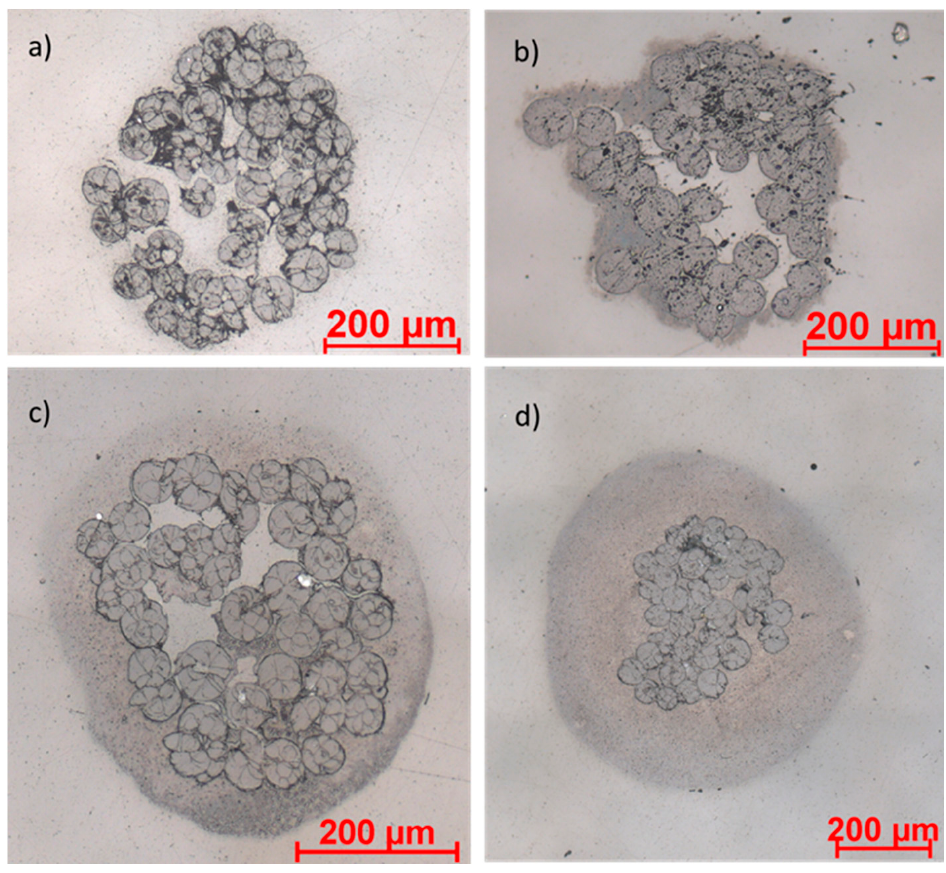
Figure 3. Cross-sections of coated multifilament yarns with 10 wt% CNT in the SC: ( a ) 2% SC, ( b ) 6% SC, ( c ) 8% SC and ( d ) 10% SC. Table 1. Electrical and mechanical properties of multifilament yarns coated with different specifications of TPU–CNT–NMP